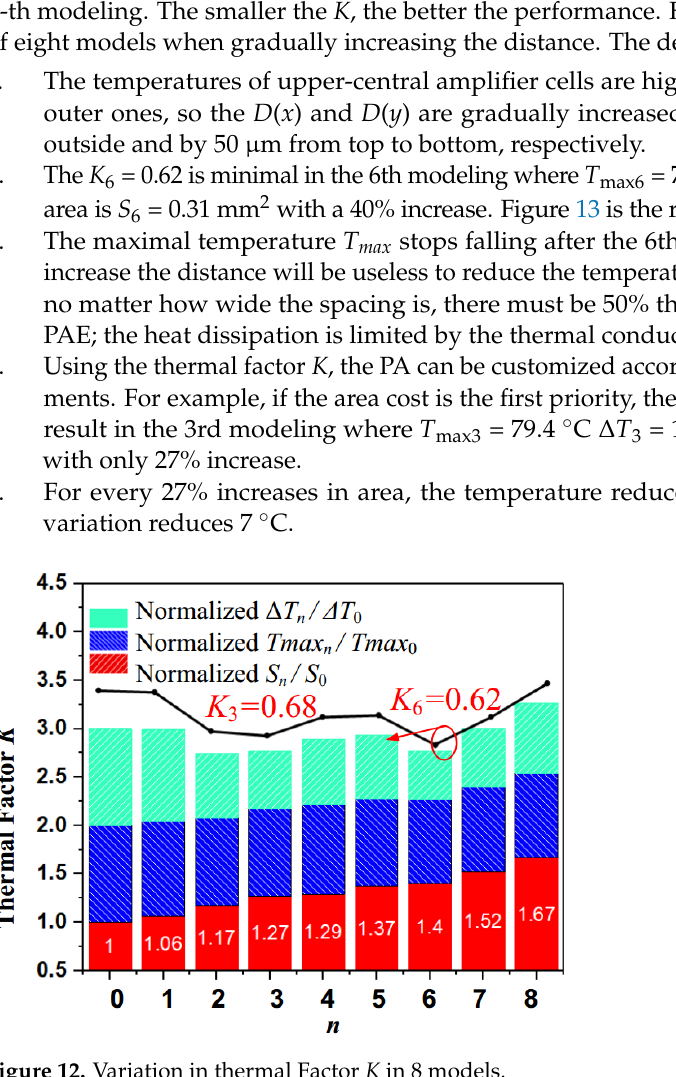
Figure 12. Variation in thermal Factor K in 8 models.